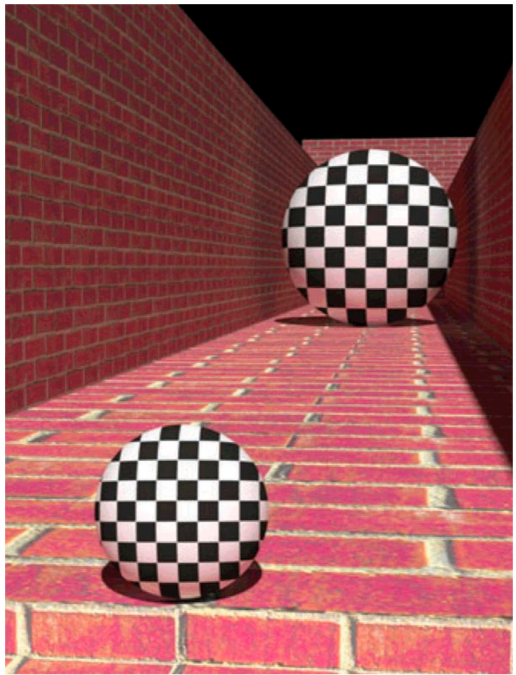
Figure 1. Demonstration of pictorial size constancy in the stimulus used by [2] (© Scott